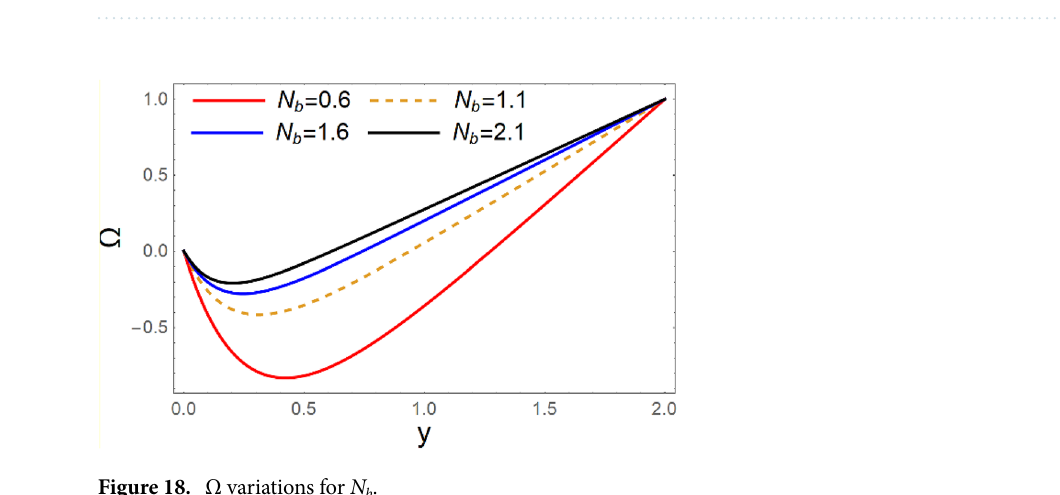
Figure 18. Ω variations for N b